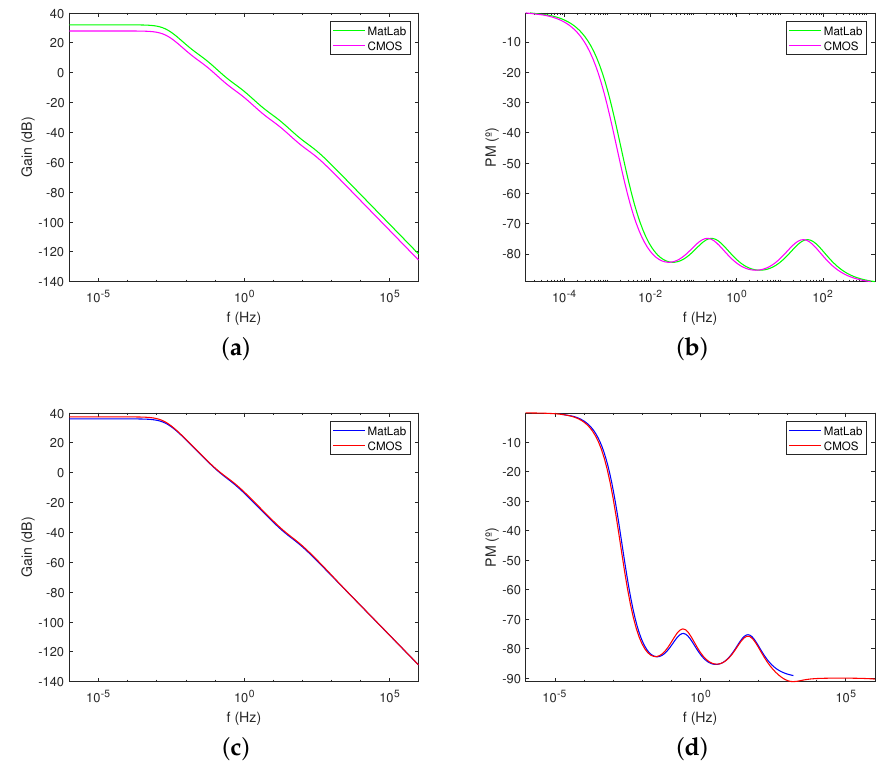
Figure 7. Frequency responses of the two fractional-order integrators considering ideal transfer function approximation in MatLabTM and HSPICETM simulation using CMOS transistor